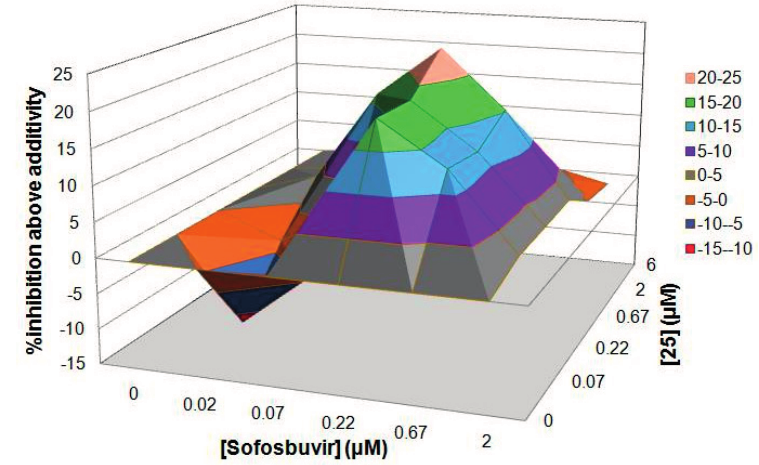
Figure 2. Result of combination study between 25 and